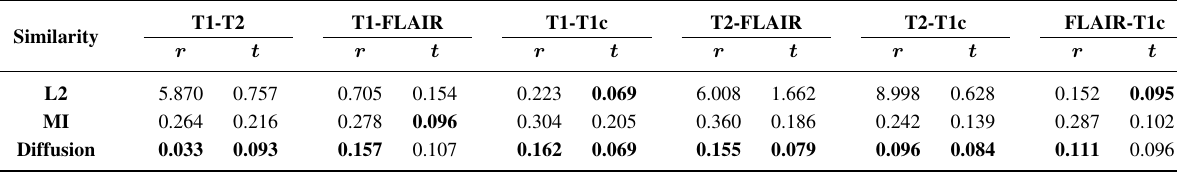
Table 2. Mean (rigid) registration error for BRATS data sets. Rotation errors r are in degrees, and translation errors t are in